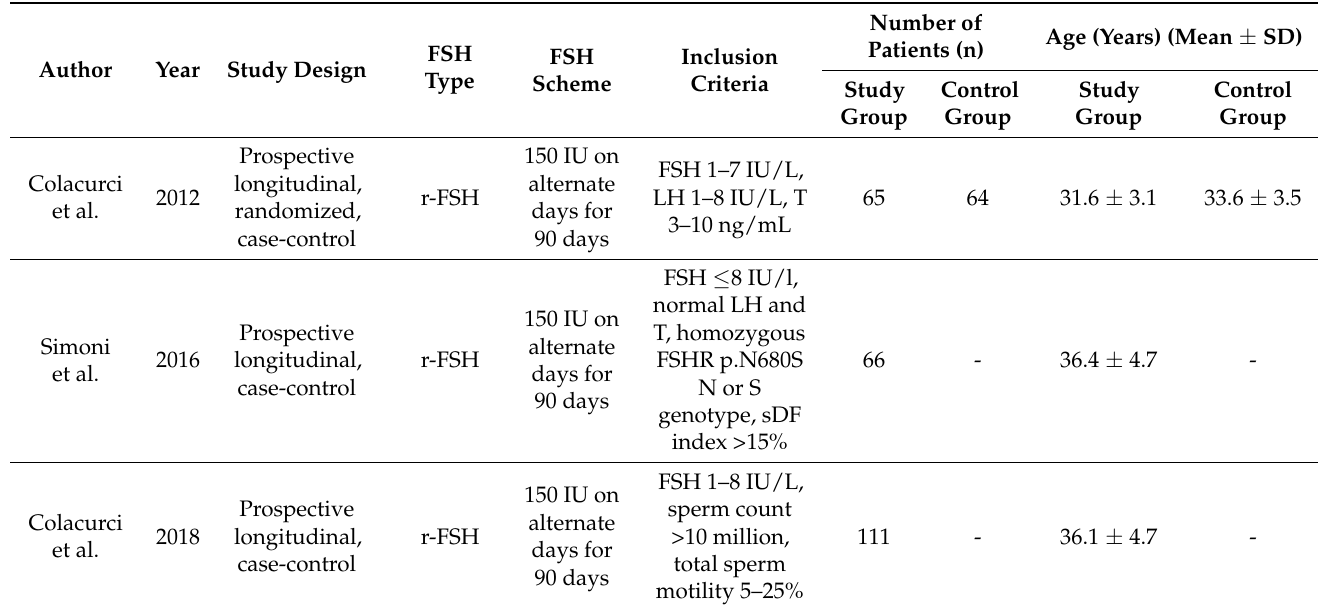
Table 1. Characteristics of clinical trials included in the analysis in which male partners of infertile couples were treated with follicle stimulating hormone (FSH).